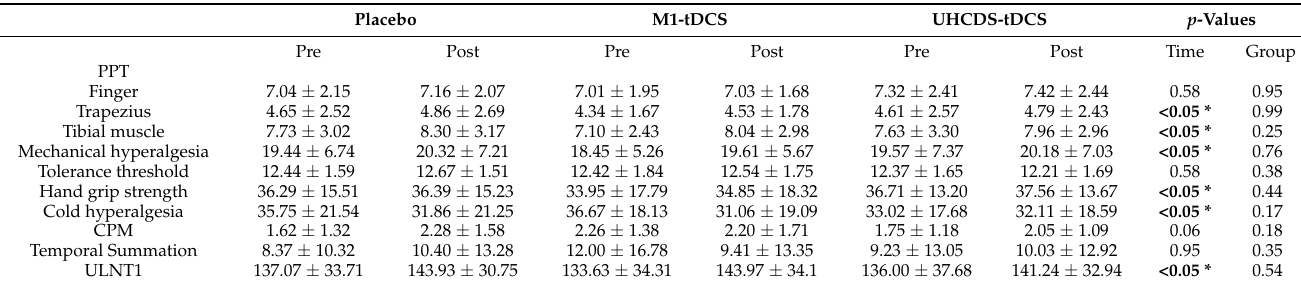
Table 2. ANOVA comparing effects between M1-tDCS vs. UHCDS-tDCS vs. sham-tDCS on pain processing variables and strength. Placebo M1-tDCS UHCDS-tDCS p -Values Pre Post Pre Post Pre Post Time Group PPT